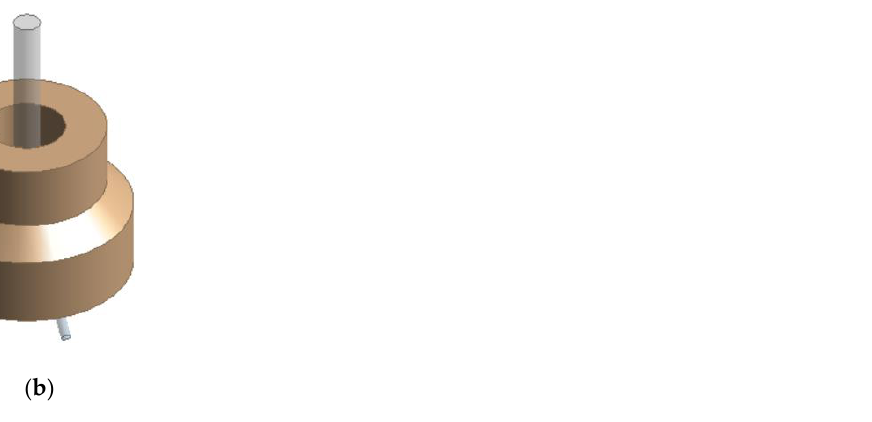
Figure 7. Pre-stage flow field model: ( a ) 3D model; and ( b ) flow passage DM model. Table 1. Key structural parameter table.